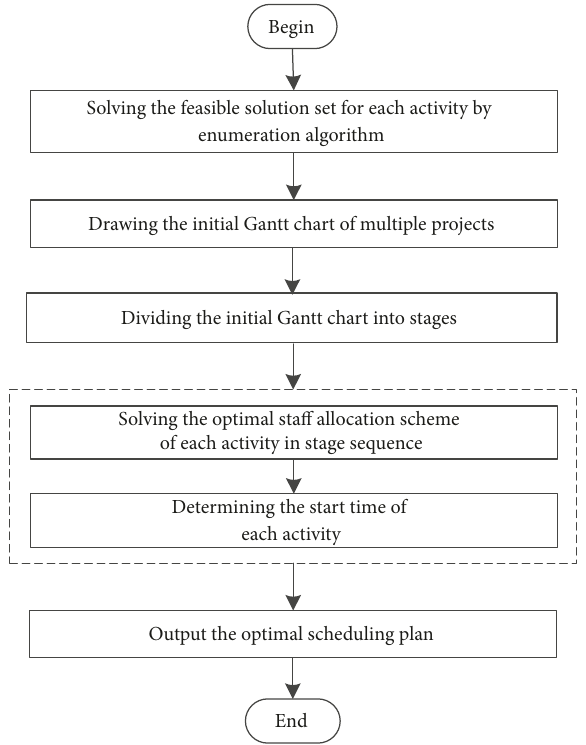
Figure 3: The flowchart of algorithm for special